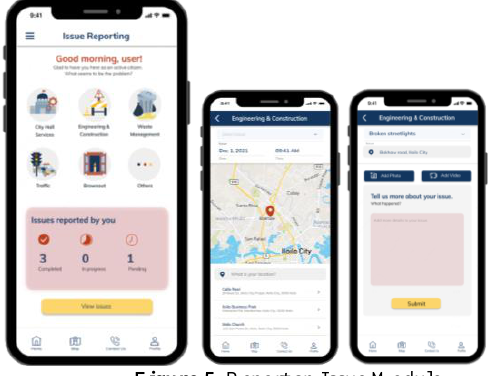
Figure 5. Report an Issue